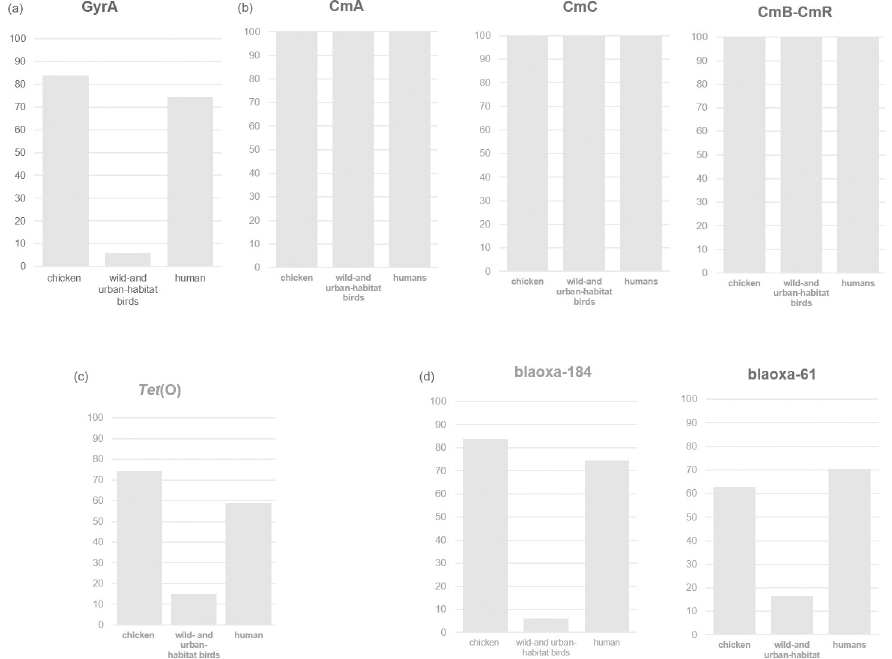
Fig 2. Percentage of isolates harbouring gyr A and tet (O) genes and the multi-drug resistance-related cmeABC operon, and the percentage of B-lactam genes in the resistant isolates.